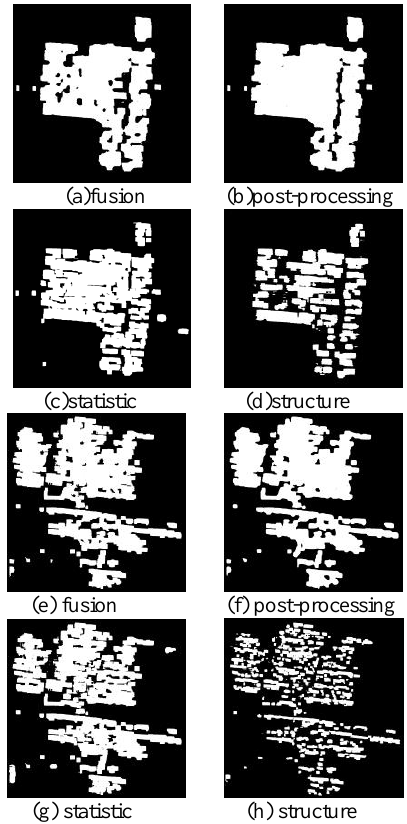
Figure 6 classification results and post-processing